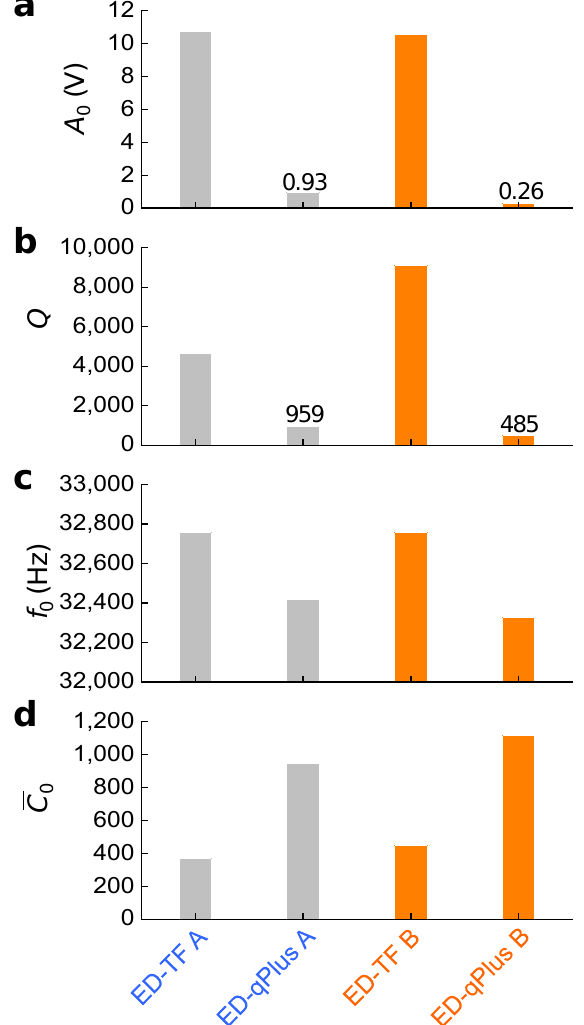
Figure 3. Dynamic characteristics of the electrically driven tuning fork and qPlus sensor. From the resonance curves (Figure 2) and their fit curves using Equation (1), one can uniquely determine the four dynamic characteristics, ( a ) A 0 , ( b ) Q , ( c ) f 0 , and ( d ) C 0